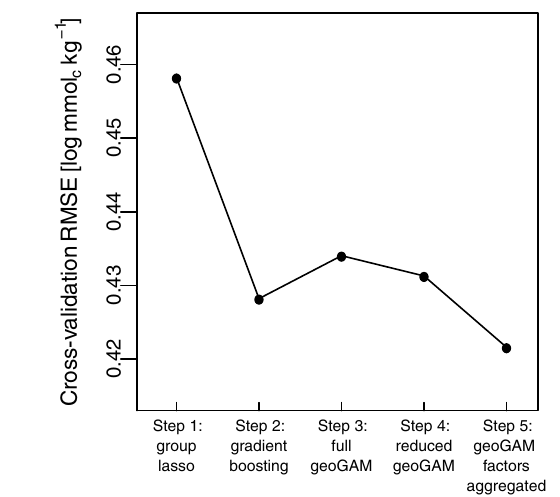
Figure 4. Coverage of one-sided bootstrapped prediction intervals (0, e q α ( s )) for 528 ECEC validation samples plotted against nominal probability α used to construct the upper limit q α of the prediction intervals (vertical lines mark the 5 and 95% probabilities). Table 3. Validation statistics for ( a ) log-transformed and ( b )